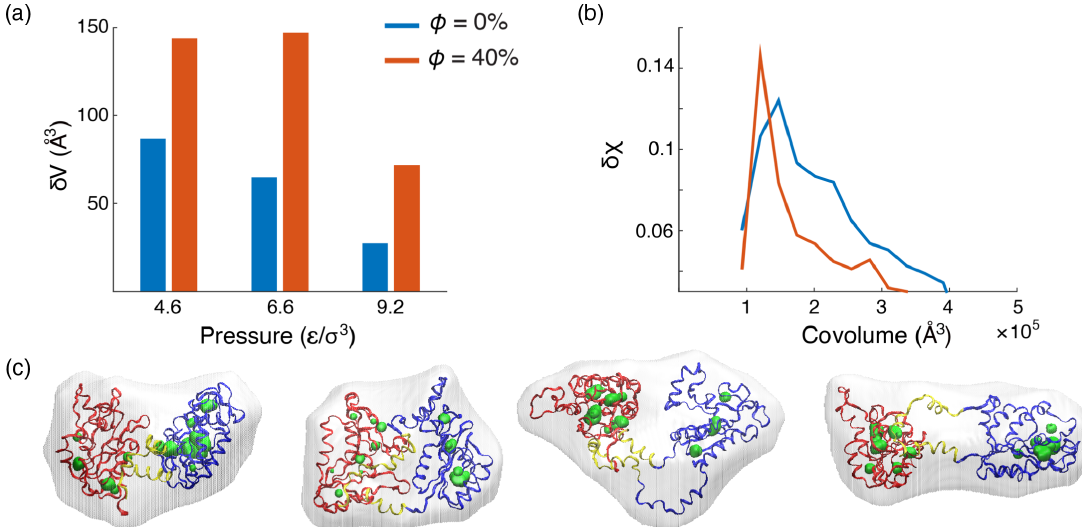
FIG. 5. Cavity volume and structural fluctuations near the critical regime. (a) Cavity volume fluctuations δ V 2 ¼ h V 2 i − h V i 2 (or T= ϵ 0 ¼ 0 . 97 and σ 3 P= ϵ 0 ¼ 4 . 6 , 6.6, and 9.2 with (orange line) and without (blue line) proportionally compressibility) of PGK at k B crowding ( ϵ 0 = σ 3 ≈ 76 MPa). (b) Overlap fluctuations δχ 2 ¼ h χ 2 i − h χ i 2 as a function of the covolume at pressure σ 3 P= ϵ 0 ¼ 6 . 6 . T= ϵ 0 ¼ 0 . 97 and σ 3 P= ϵ 0 ¼ 6 . 6 with covolumes approximately (c) Conformations from the ensemble in the presence of crowding at k B equal to 1 . 1 × 10 5 Å 3 and cavities approximately equal to 200 Å 3 . The leftmost conformation is a crystal state. The following structures from left to right have a χ ¼ 0 . 31 , 0.38, and 0.48. The N and C domains and hinge are in red, blue, and yellow, respectively. Covolumes are shown as translucent surfaces surrounding the protein, and cavity surfaces are shown in